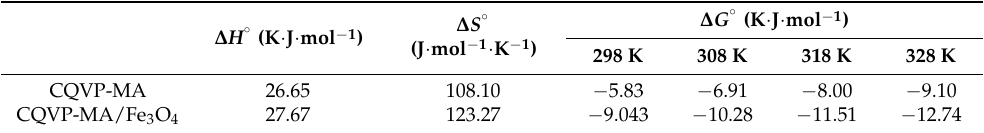
Figure 12. Van’t Hoff plots for the adsorption of CBB dye onto the surfaces of CQVP/MA and CQVP/MA-Fe 3 O 4 . Table 5. Thermodynamic parameters for adsorption of CBB dye onto CQVP/MA and CQVP/MA-Fe 3 O 4 .